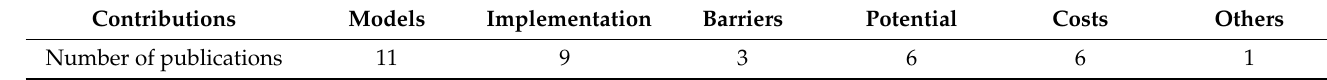
Table 5. Trend of research on demand response in the